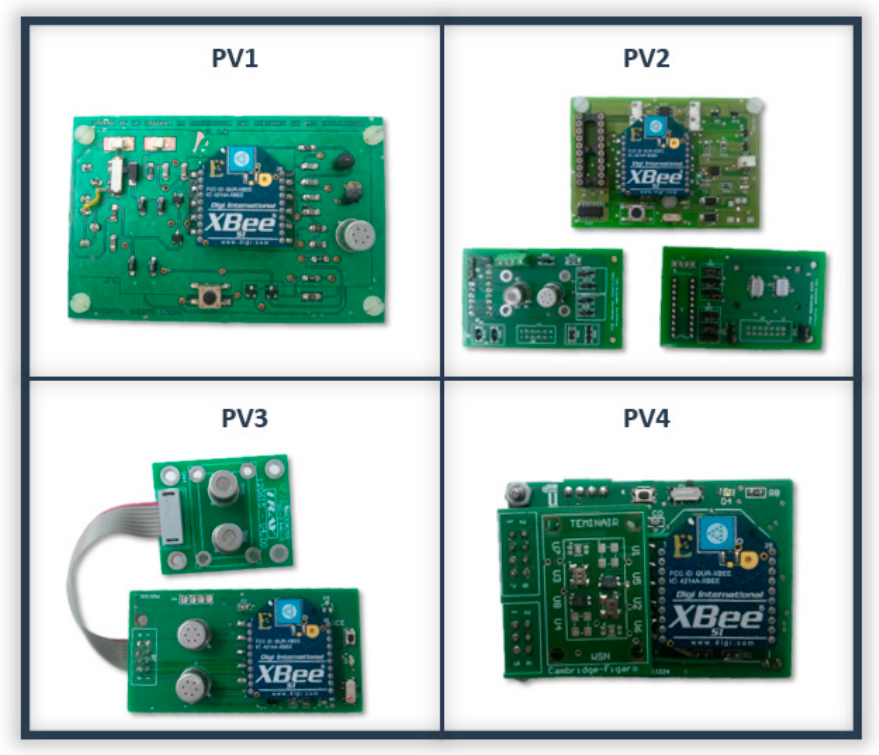
Figure 8. Real images of the prototypes developed.